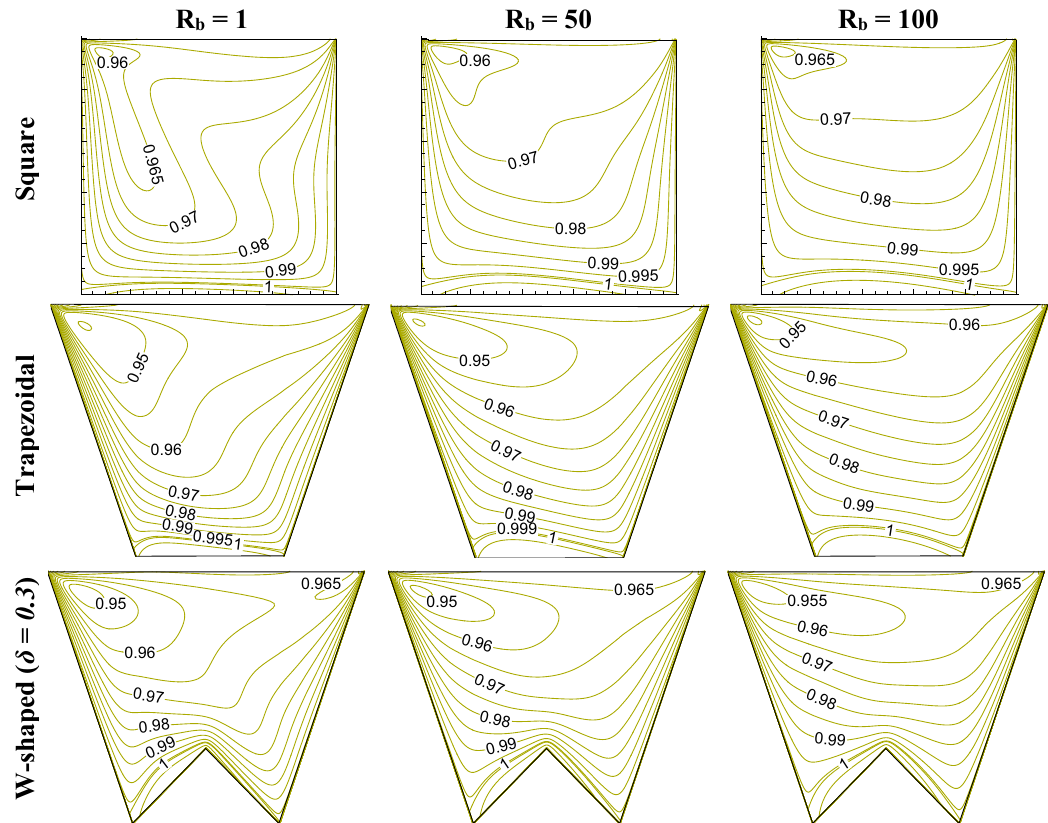
Figure 5. Microorganisms isoconcentration ( N ) for different geometric cavity at Le = Pe = 1, Gr = 10 4 , Da = 10 –3 , Ha = 30 for square, trapezoidal and W-shaped